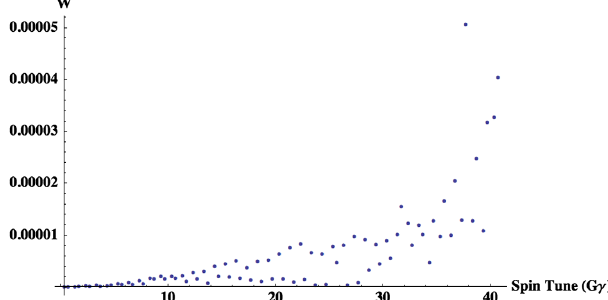
FIG. 3. DEPOL calculated intrinsic spin resonances for RCS at 10 mm mrad normalized emittance w ¼ j ε